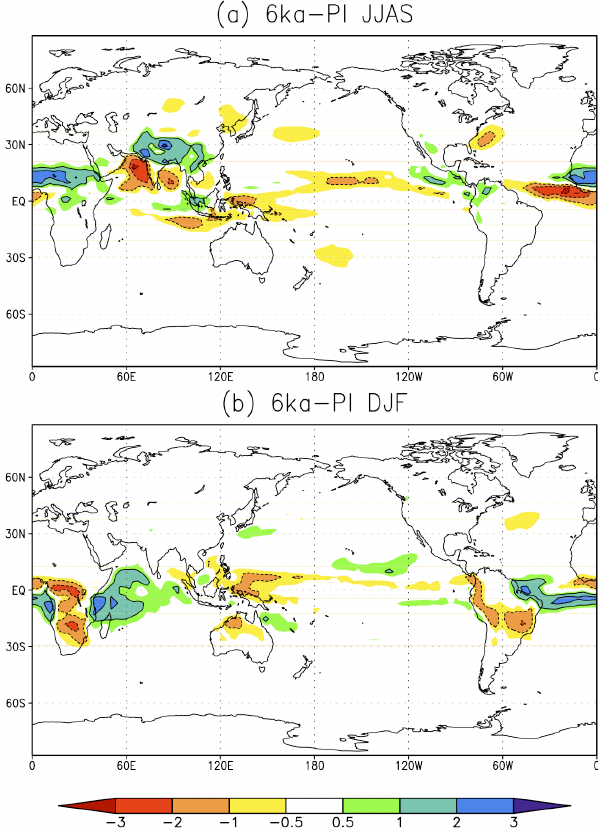
Fig. 7. The change in 2m air temperature 6ka PI ( ◦ C) for (a) JJAS and (b) DJF. Figure 7. The change in 2m air temperature 6ka-PI (°C) for (a) JJAS and (b) DJF. 3 4